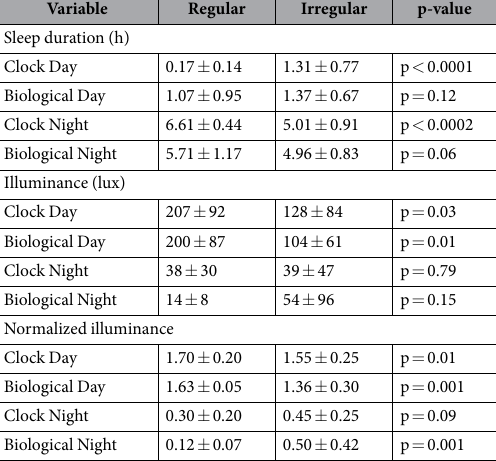
Table 1. Summary metrics for average sleep and light for Regular and Irregular groups. Values for each group are mean ± standard deviation. Clock Day is 10:00 to 22:00, Clock Night is 22:00 to 10:00. Biological Night is salivary dim light melatonin onset (DLMO) to DLMO + 10 h (i.e., 10 h after DLMO). Biological Day is DLMO + 10 h to DLMO. Normalized illuminance is illuminance divided by the individual’s average daily illuminance. A nonparametric statistical test (ranksum) was used to test for differences between